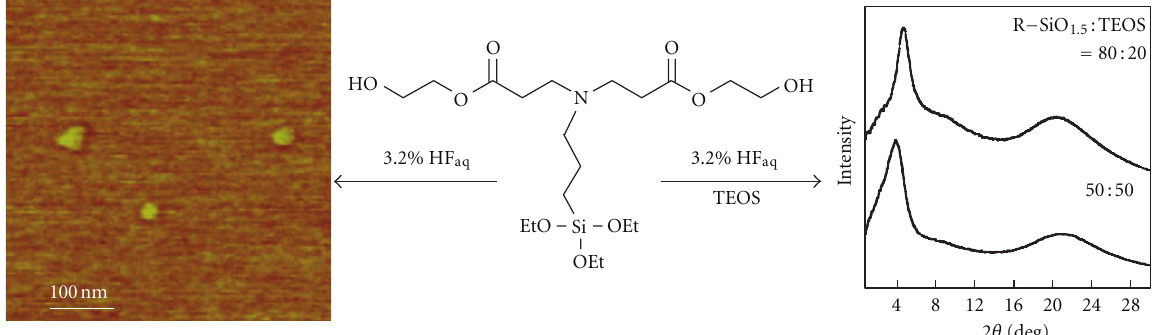
Figure 5: SFM height image and XRD spectra of water-soluble silsesquioxane-based nanoparticles synthesized by hydrolytic (co-)condensation of the hydroxyl-functionalized triethoxysilane precursor derived from 2-hydroxyethyl acrylate (HEA). Reprinted with permission from [35]. Copyright 2007 American Chemical